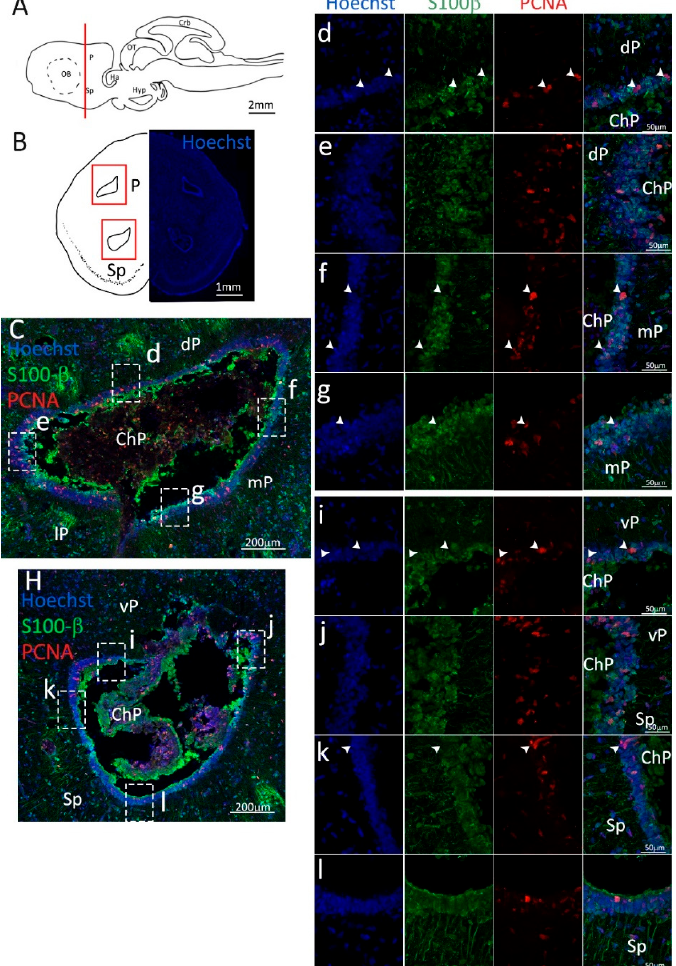
Figure 5. Localization of PCNA (red) and S100 β (green) positive cells in the posterior telencephalon of S. canicula . ( A ) Sagittal representation of S. canicula brain. The red line indicates the rostro-caudal localization of the section represented in the panel. ( B ) Coronal map of the posterior telencephalon. On the right, a real coronal tissue section is stained with Hoechst 33342 to show nuclei distribution; on the left, a cartoon is drawn to indicate anatomical references. Red rectangles identify the general area from which images are taken. ( C ) Dorsal ventricle of the posterior telencephalon. This part of the ventricle is formed by dP, mP, and lP regions of the brain. Radial glial cells (S100 β + , green) are tightly packed around the ventricle. ( d ) Magnification of the neurogenic niche localized in the dP. White arrowheads indicate PCNA + /S100 β − cells. ( e ) Magnification of the neurogenic niche localized in the dorsolateral pallium. ( f ) Magnification of the neurogenic niche localized in the mP. White arrowheads indicate PCNA + /S100 β − cells. ( g ) Magnification of the neurogenic niche localized in the mP. White arrowheads indicate PCNA + /S100 β − cells. ( H ) Ventral ventricle of the posterior telencephalon. This part of the ventricle is formed by vP and Sp regions of the brain. ( i , j ) Magnification of the neurogenic niche localized in the vP. White arrowheads indicate PCNA + /S100 β − cells. ( k , l ) Magnification of the neurogenic niche localized in the Sp. White arrowheads indicate PCNA + /S100 β − cells. Abbreviations: P: pallium, Sp: subpallium, dP: dorsal pallium, mP: medial pallium, lP: lateral pallium, vP: ventral pallium, ChP: choroid